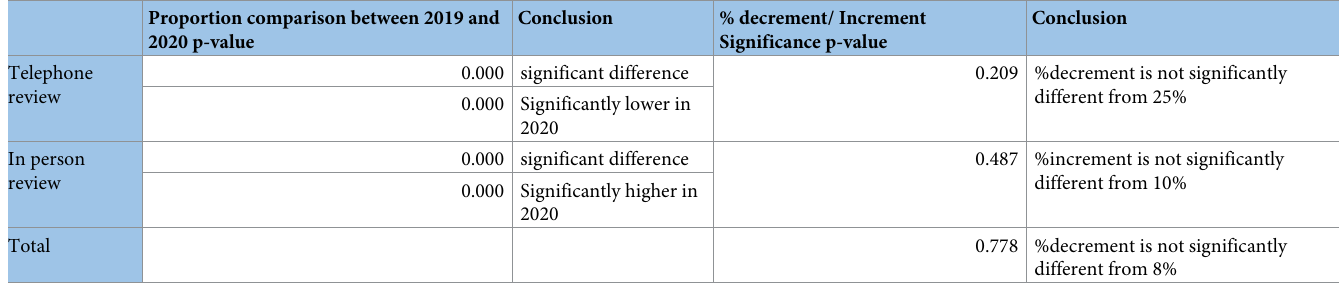
Table 5. Proportional comparison of day-cases based episodes reviewed over the phone during the study period compared to